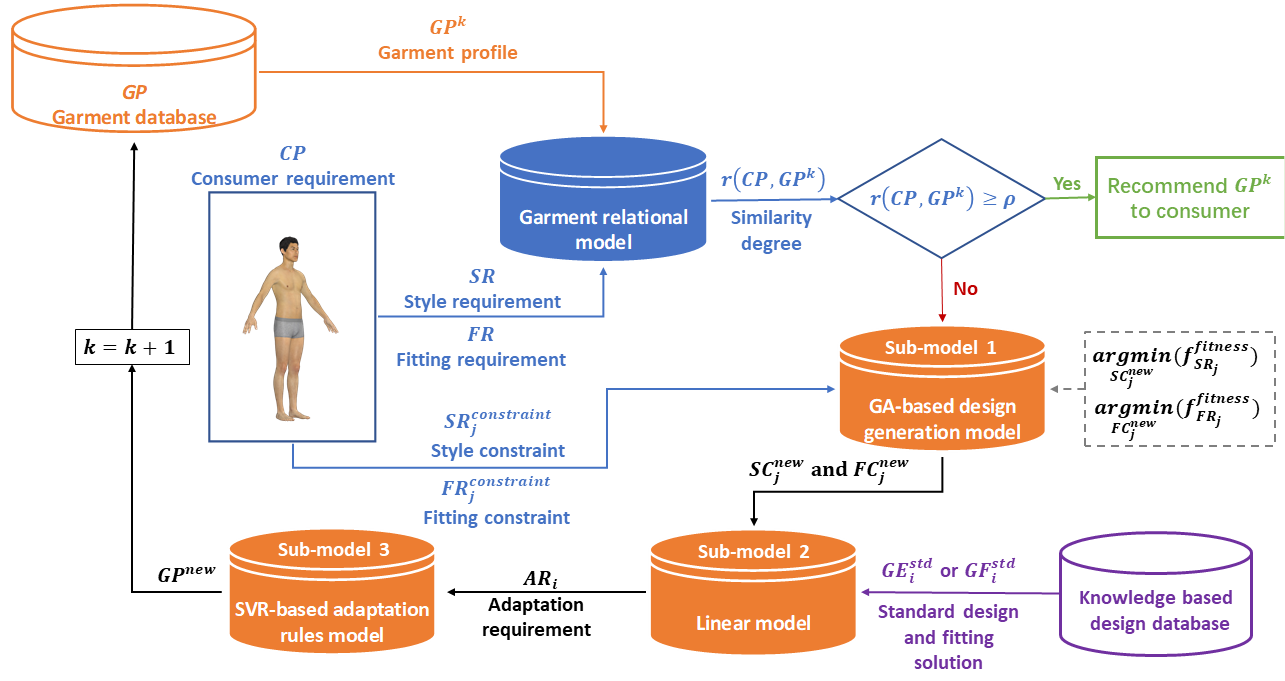
Figure 3. General calculation process of the garment design adaptation model.